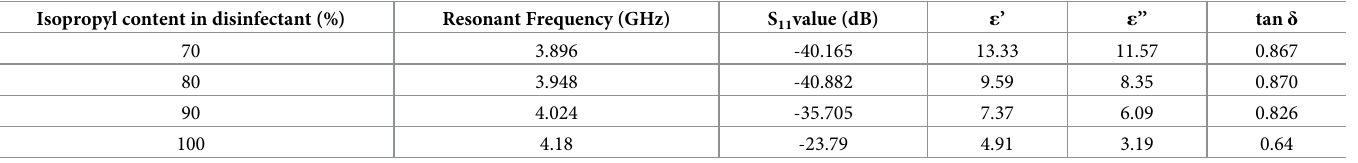
Table 4. Resonant frequency, S 11 and dielectric for the isopropyl alcohol in disinfectant. Isopropyl content in disinfectant